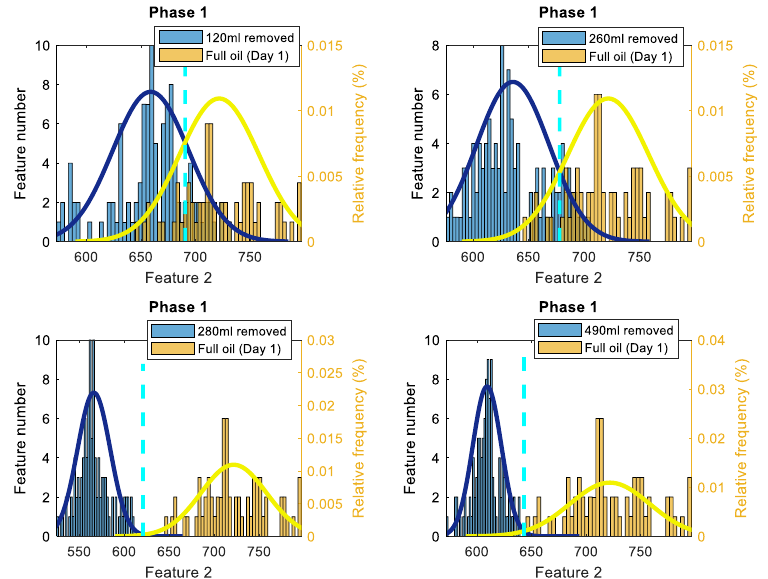
Figure 10. Histograms of Feature 2 for phase 1 of the current signals, comparing the standard oil level (Day 1) to 120 mL, 260 mL, 280 mL and 490 mL of the removed oil cases (the solid lines are the PDF, and the dashed lines are thresholds).